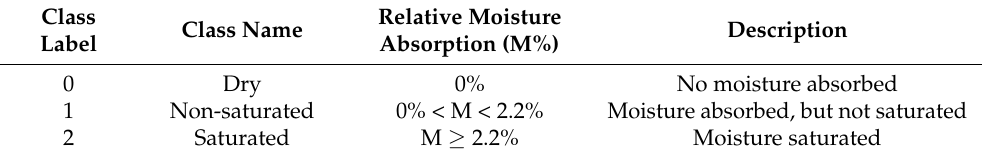
Table 1. Definitions of classes used.